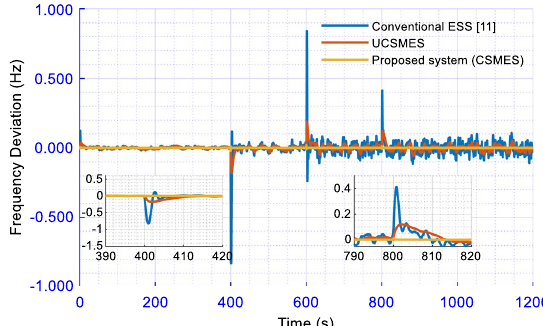
Fig. 13 Frequency deviation of the considered system for scenario B at 50% of system inertia